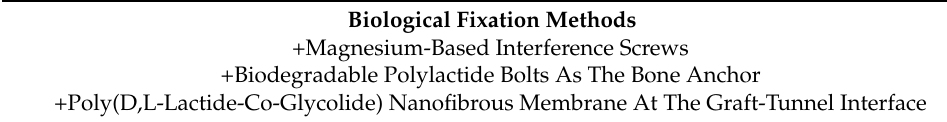
Table 6. Biomaterials used in anterior cruciate ligament